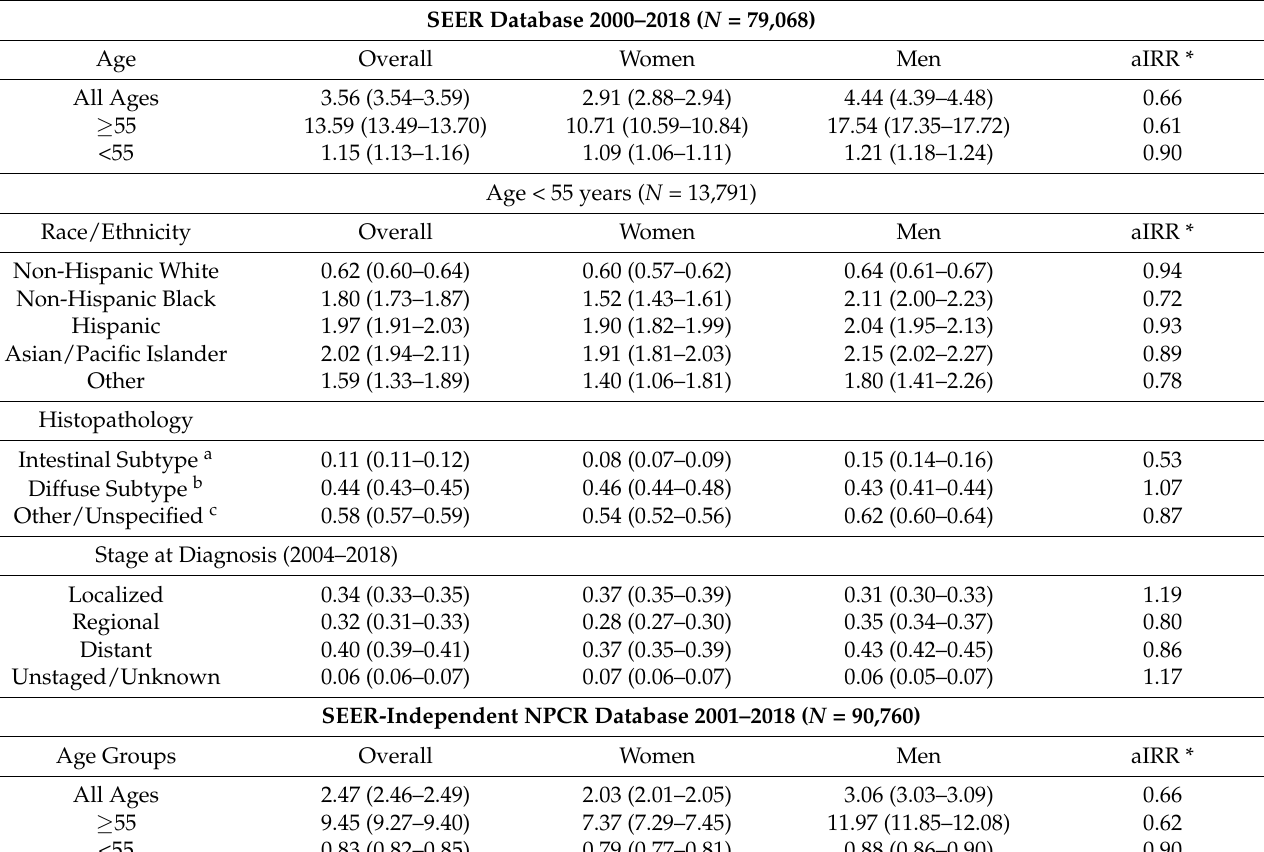
Table 1. Overall Incidence Rates (per 100,000 population) of Primary Non-cardia Gastric Cancer in the U.S. SEER Database 2000–2018 ( N =